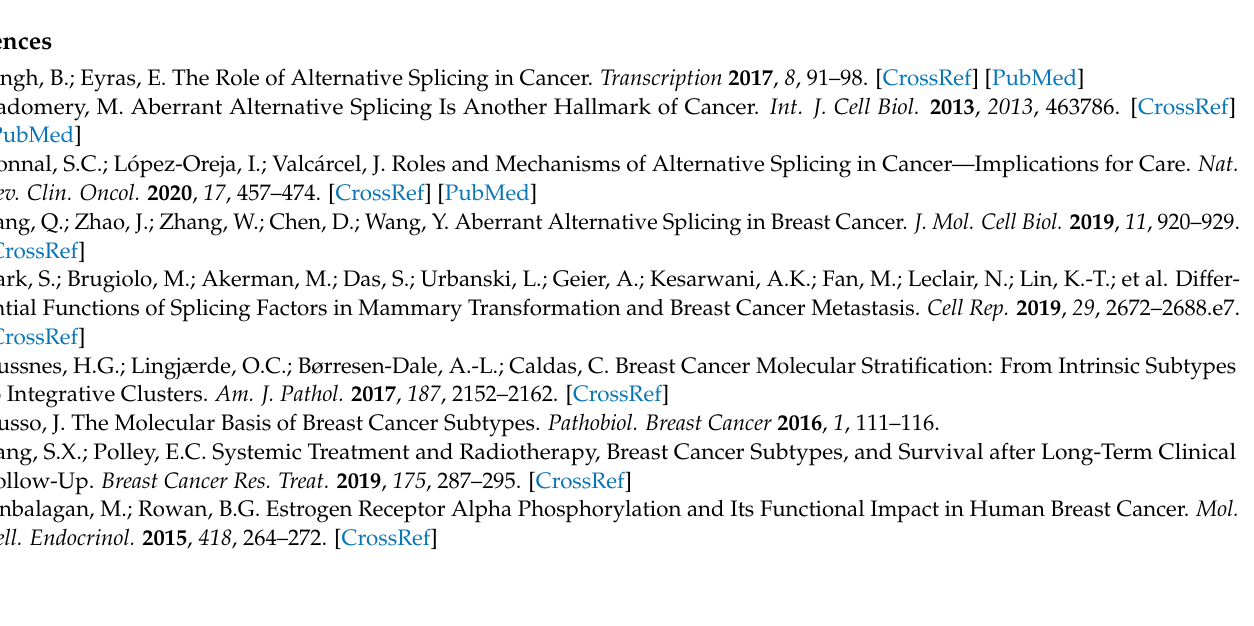
Table S2: results of RBPs gene differential expression analysis between siER α and siCTRL conditions and their overlap with GSE30290 and GSE75492 studies; Supplementary Materials Table S3: results from differential isoform usage (dIU) analysis between siER α and siCTRL conditions; Supplementary Materials Table S4: results from differential alternative splicing analysis between siER α and siCTRL conditions; Supplementary Materials Table S5: table of the overlapping ASEs between this study and both GSE30290 and GSE75492 studies; Supplementary Materials Table S6: results of the RBP-binding motif enrichment analysis; Supplementary Materials Table S7: results of the overlap between ER α HITS-CLIP peaks and the regions involved in apoER α -modulated ASEs; Supplementary Materials Table S8: results from the analysis of apoER α -modulated ASEs in primary tumor samples; Supple- mentary Materials Table S9: results from the analysis of the overlap between CELF1 CLIP-seq peaks and apoER α -modulated ASEs. Supplementary Materials Table S10: overlap of apoER α -regulated RBP genes with Keodoot et al. study [43]. Supplementary Materials Table S11: ER ChIP-Seq data analysis for direct RBP gene targets